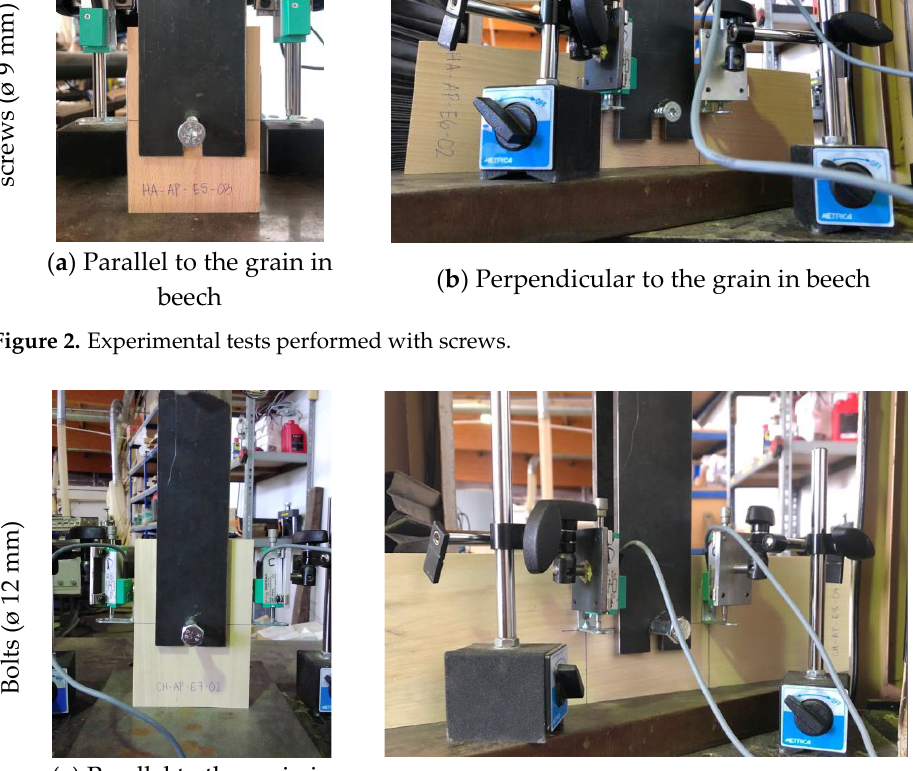
Figure 3. Experimental tests performed with bolts.